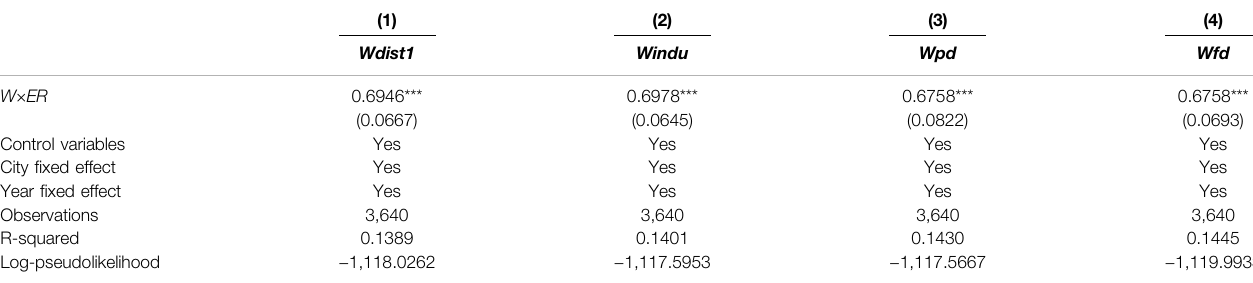
TABLE 8 | Estimates for other spatial weight matrices.